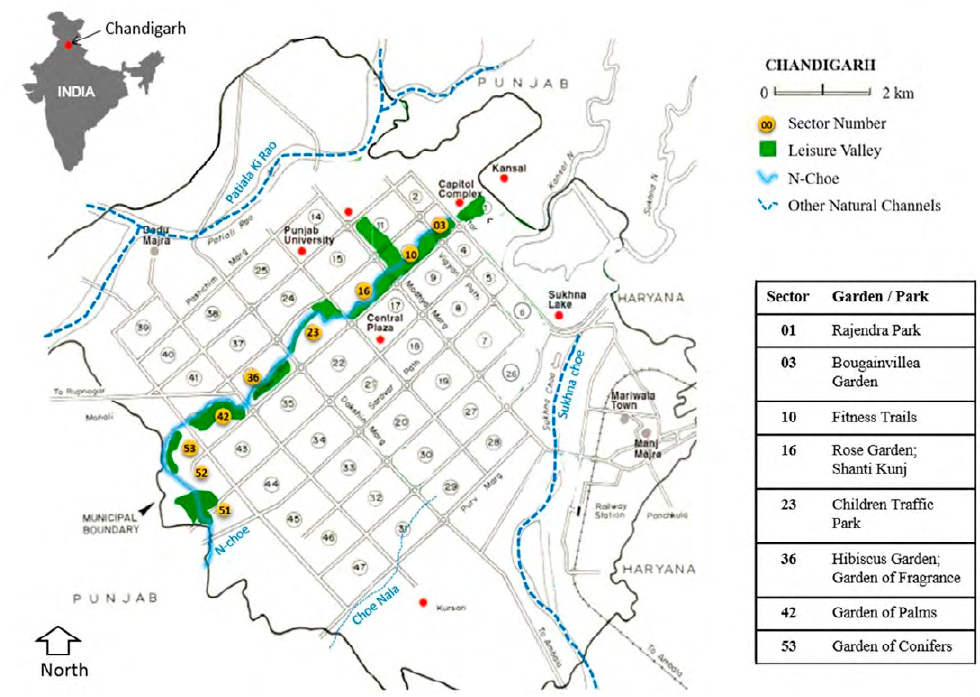
Figure 1. Location of Chandigarh city on the map of India (top-left); Location of N-choe and Leisure valley in Chandigarh Source: Developed from the tourism map of